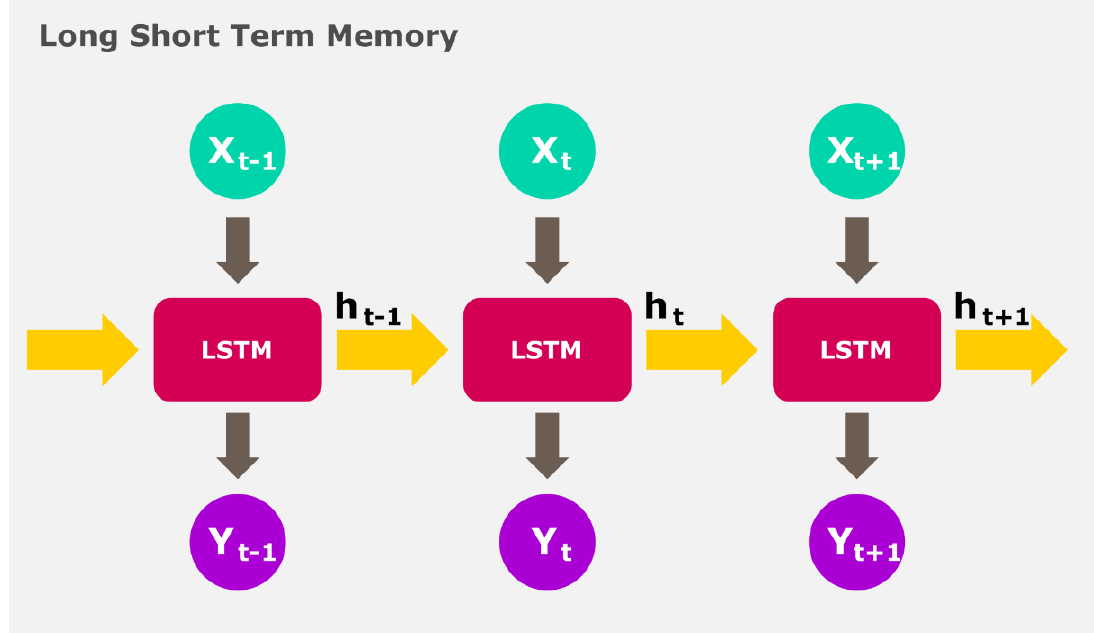
Figure 6. Illustration of the LSTM model.